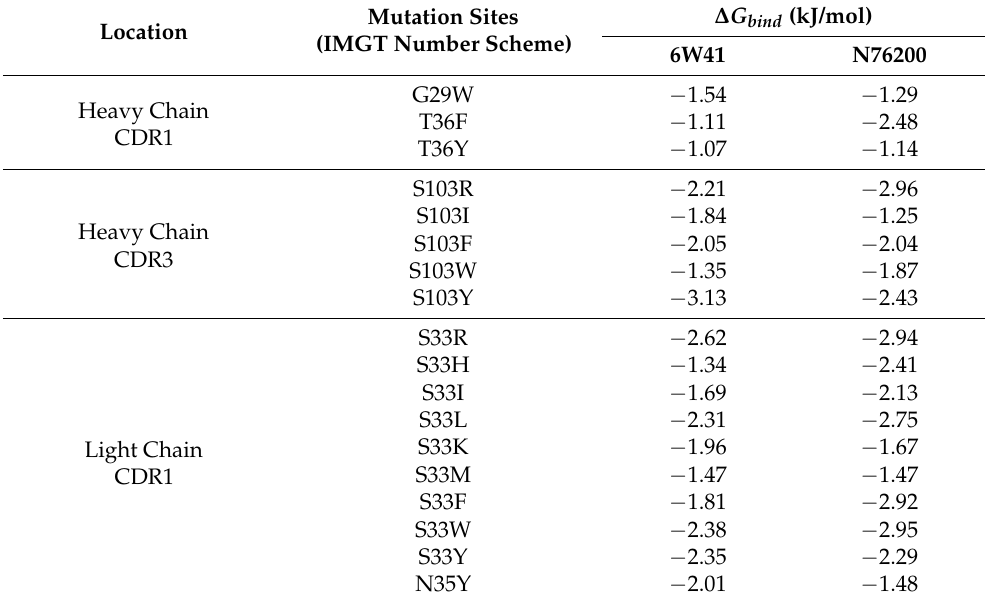
Table 1. The favorable mutation sites were filtered by the ∆ G bind value of < − 1 kJ/mol after saturation